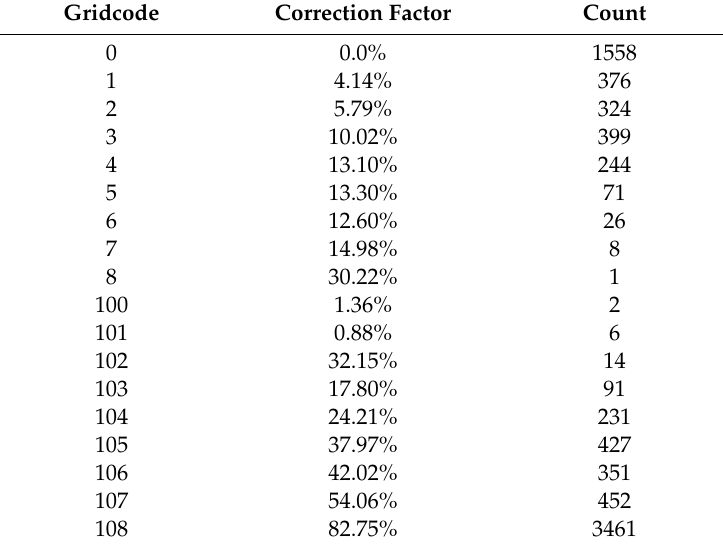
Table 1. Table of averages for mangrove extent based on convolution analyses of GMW